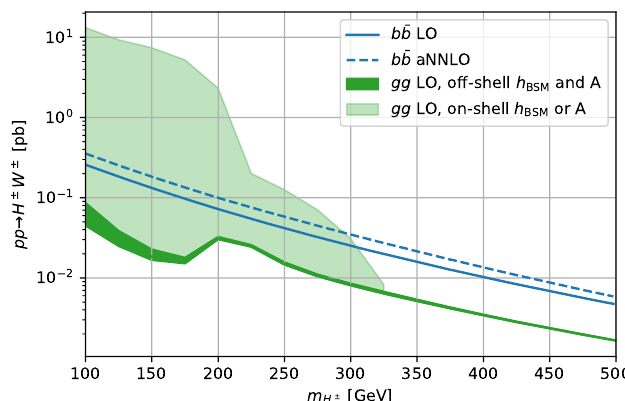
Figure 10. Contributions of the different subprocessess to the overall pp → H ± W ∓ cross section as evaluated in the 2HDM type-I assuming exact alignment and tan β = 1